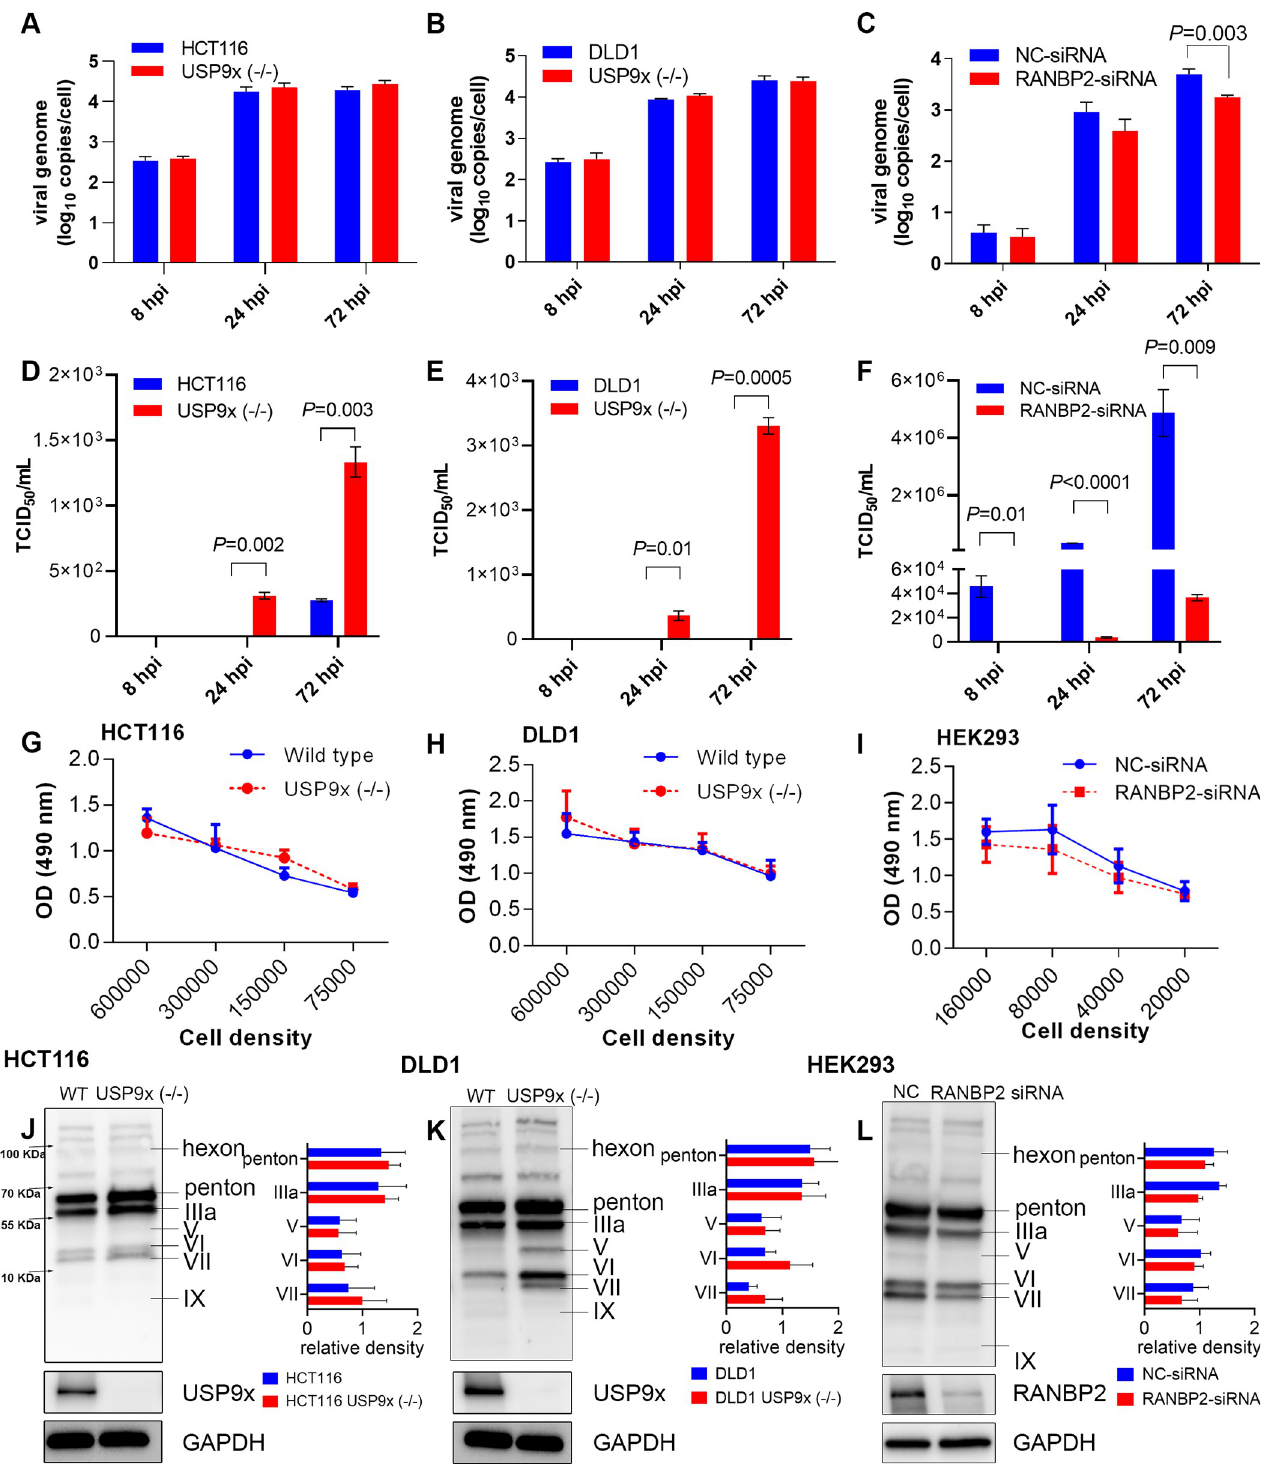
Fig 4. Human adenovirus replication and protein expression in USP9x knockout and RANBP2-siRNA knockdown cells. Quantification of virus genome copies/cell (normalized to ACTG). at an MOI of 5 at 8, 24, and 72 hours post-infection (hpi) in (A) HCT116 and (B) DLD1 wild type cells and their USP9x knockouts (-/-), each with deletions of exons 7 and 8 [87] (C) HEK293 cells were treated with NC-siRNA and RANBP-siRNA and infected at an MOI of 1 for 8, 24, and 72 hrs. Viral DNA replication was determined by q-PCR using HAdV-D37 E1A and human ACTG gene quantitation standards. Viral titers were measured in (D) HCT116 and (E) DLD1 wild type and USP9x (-/-) cells, and (F) in HEK293 cells pretreated with NC-siRNA or RANBP2 siRNA for 48 hrs, and